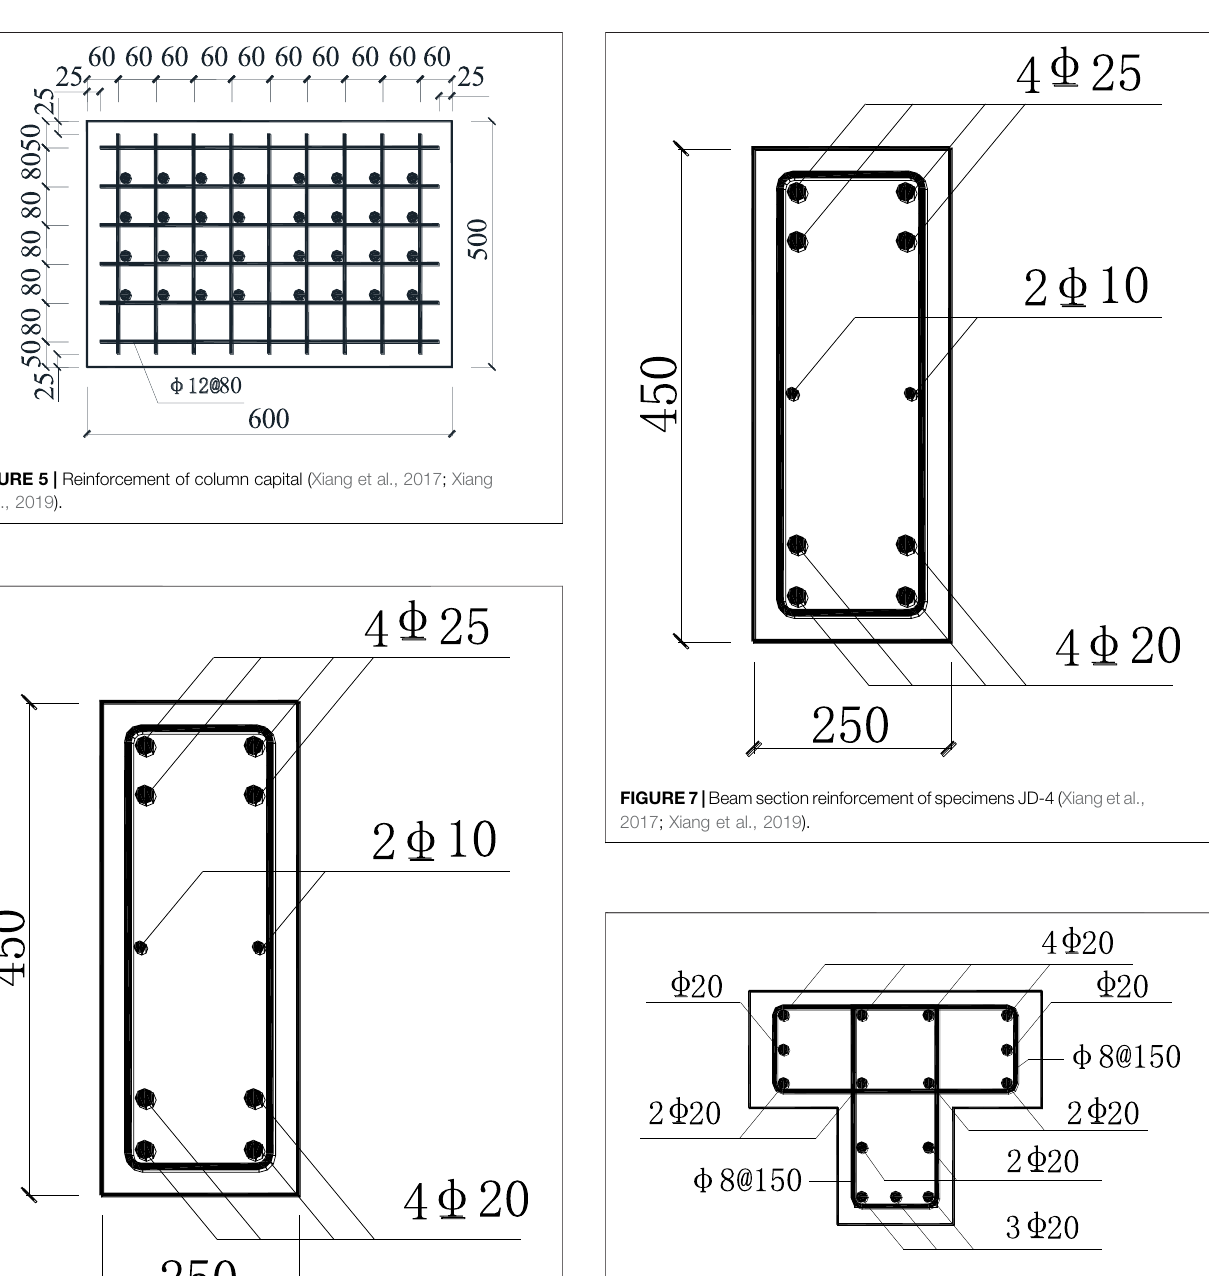
FIGURE 8 | Column section reinforcement of specimen JD-4 (Xiang et al., 2017; Xiang et al.,